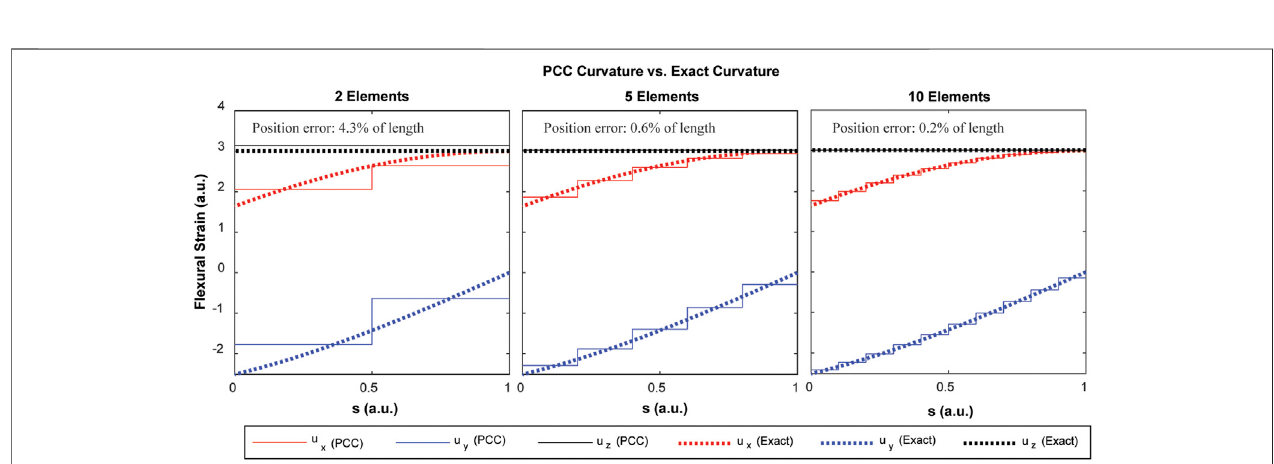
FIGURE 4 | Convergence of the PCC discretization to the exact fl exural strains of the helical rod shape depicted in Figure 3 . Note that the exact fl exural strain components are not constant functions of arc length.